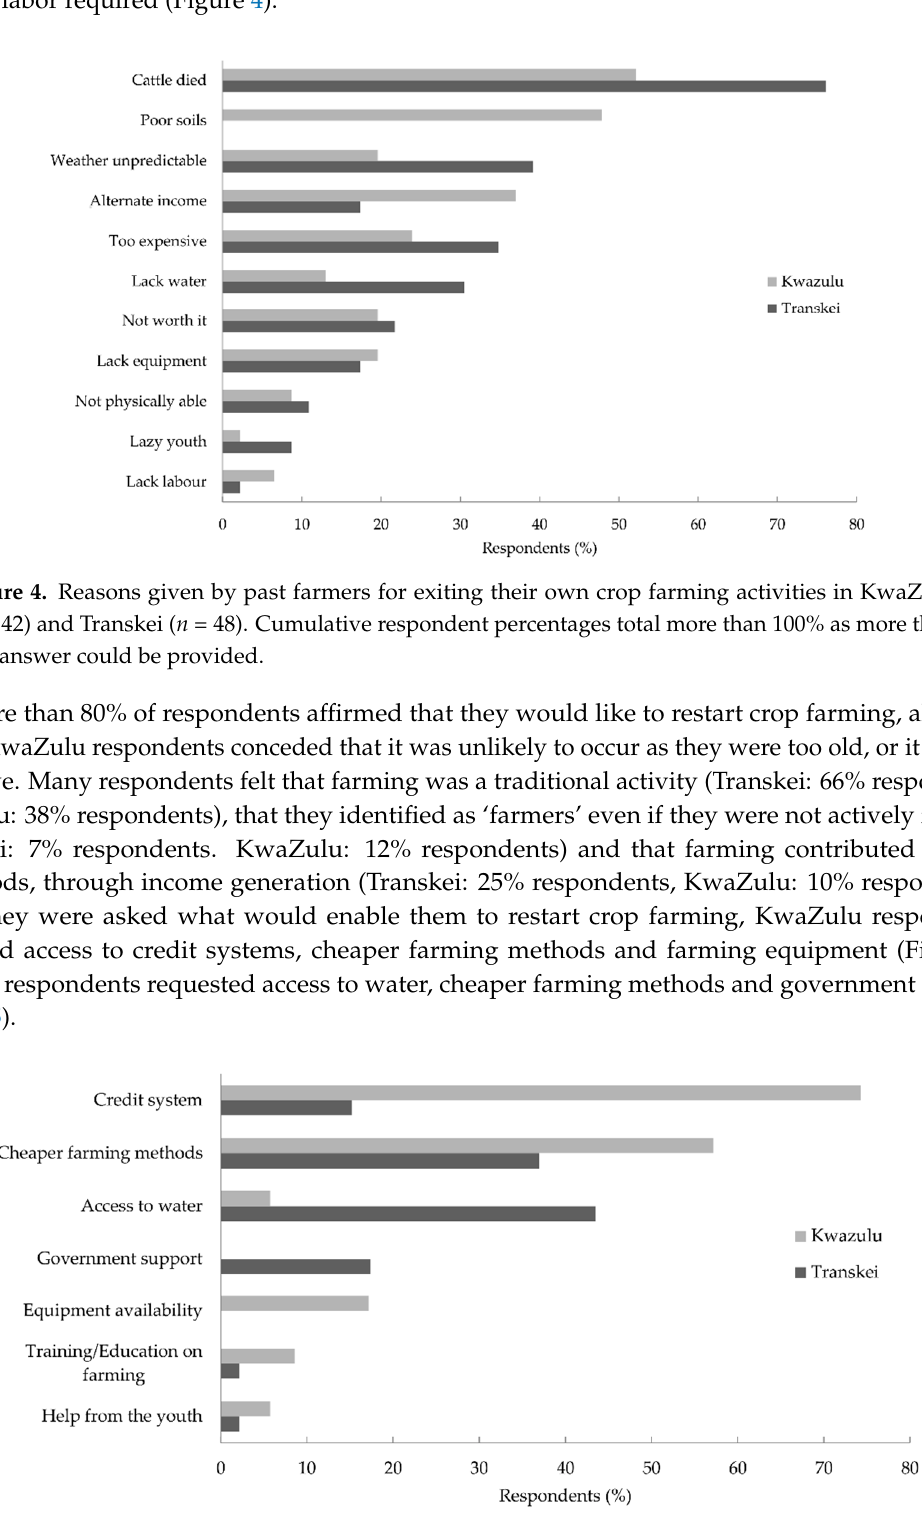
Figure 5. Past farmer requirements to restart crop farming in KwaZulu ( n = 42) and Transkei ( n = 48). Cumulative respondent percentages total more than 100% as more than one answer could be provided.